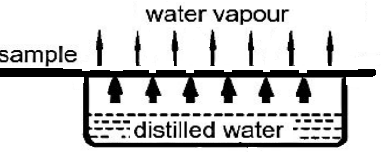
Figure 3. The laboratory setup for water vapor permeability (the cup method).